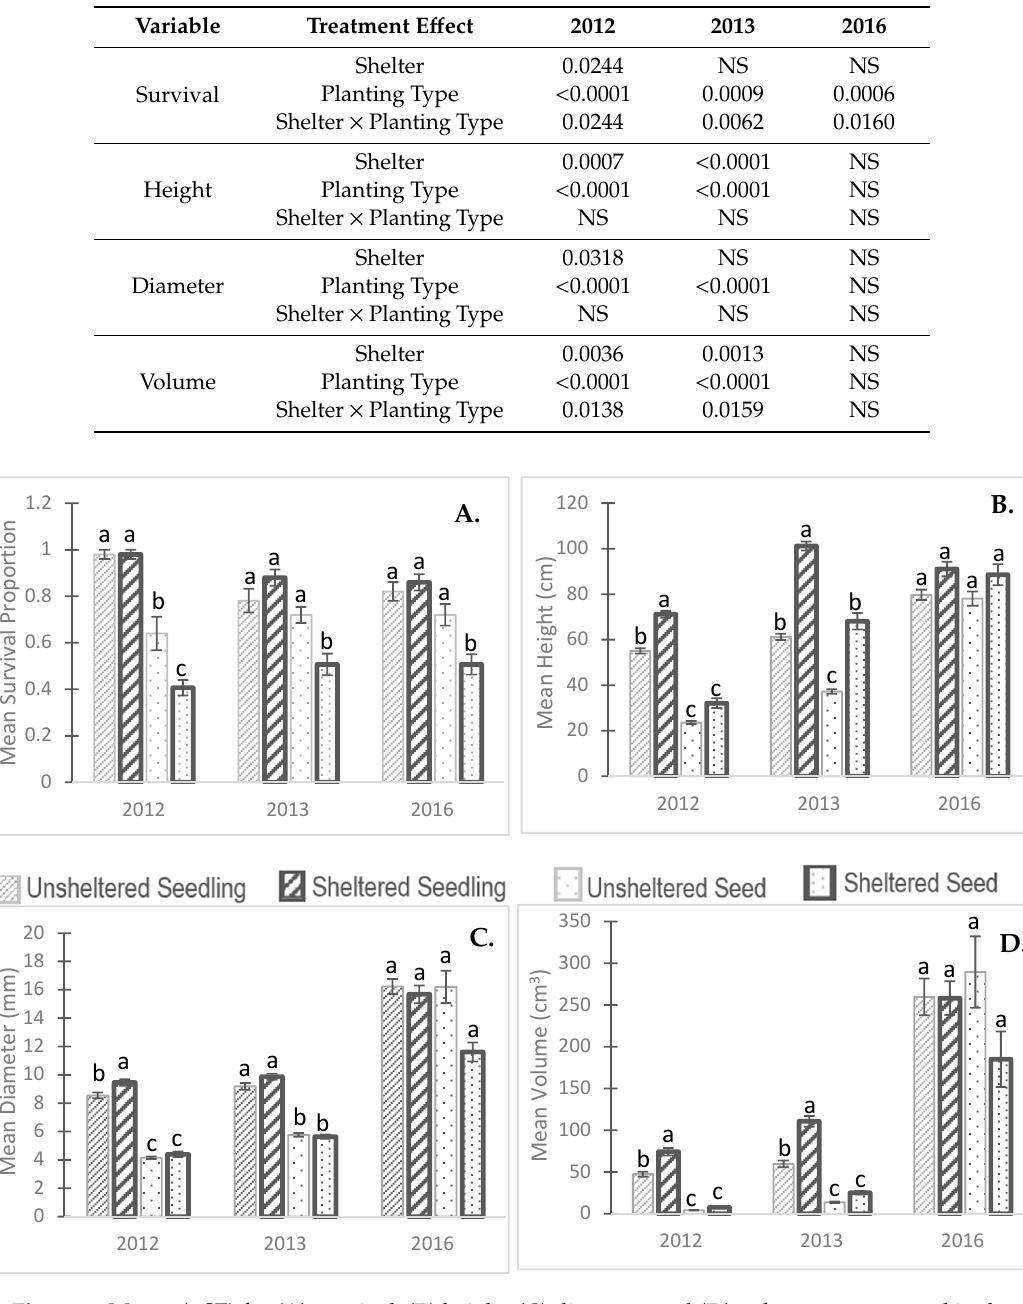
Figure 2. Means ( + SE) for ( A ) survival; ( B ) height; ( C ) diameter; and ( D ) volume, as measured in the first (2012), second (2013), and fifth (2016) growing seasons. Lowercase letters indicate a significant di ff erence between treatment means within each